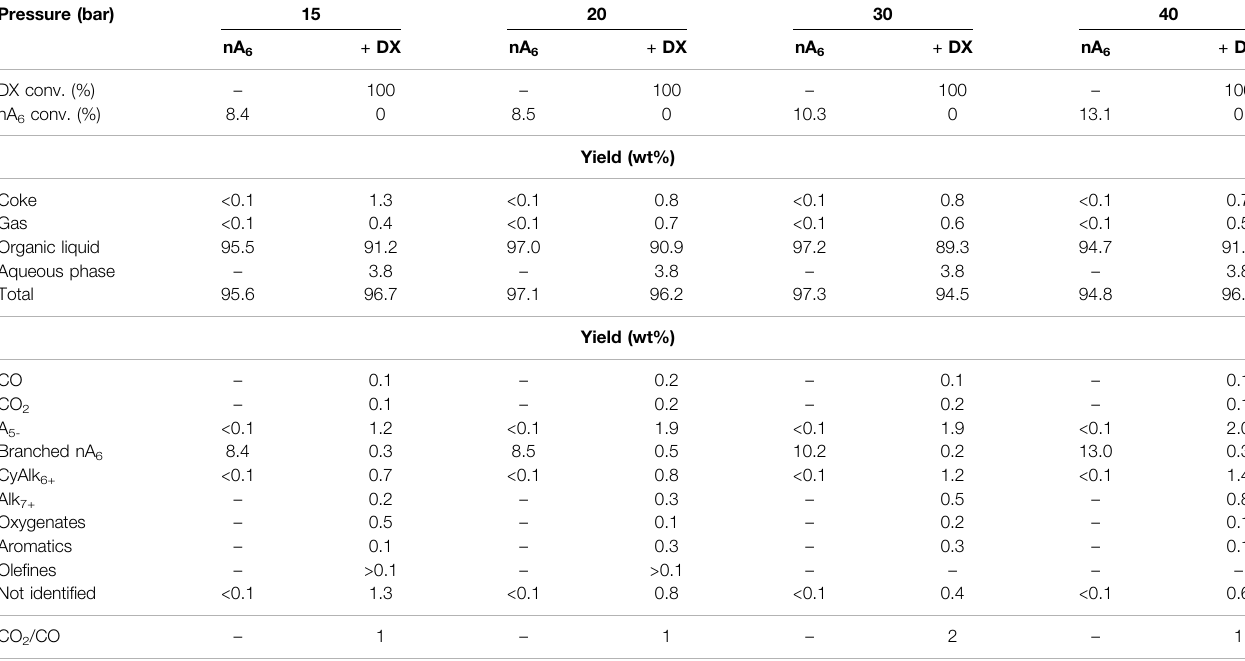
TABLE 3 | Effect of hydrogen pressure on DX HDO of 10% (wt%) DX (10 g DX + 90 g n-hexane) and 5 g of Pd/HBEA for 12 h at 250 ° C. Pressure (bar)